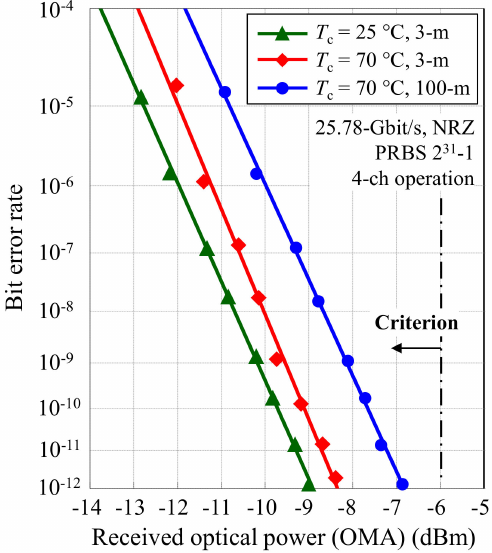
Figure 12. Measured bit-error-rate (BER) characteristics. NRZ, non-return to